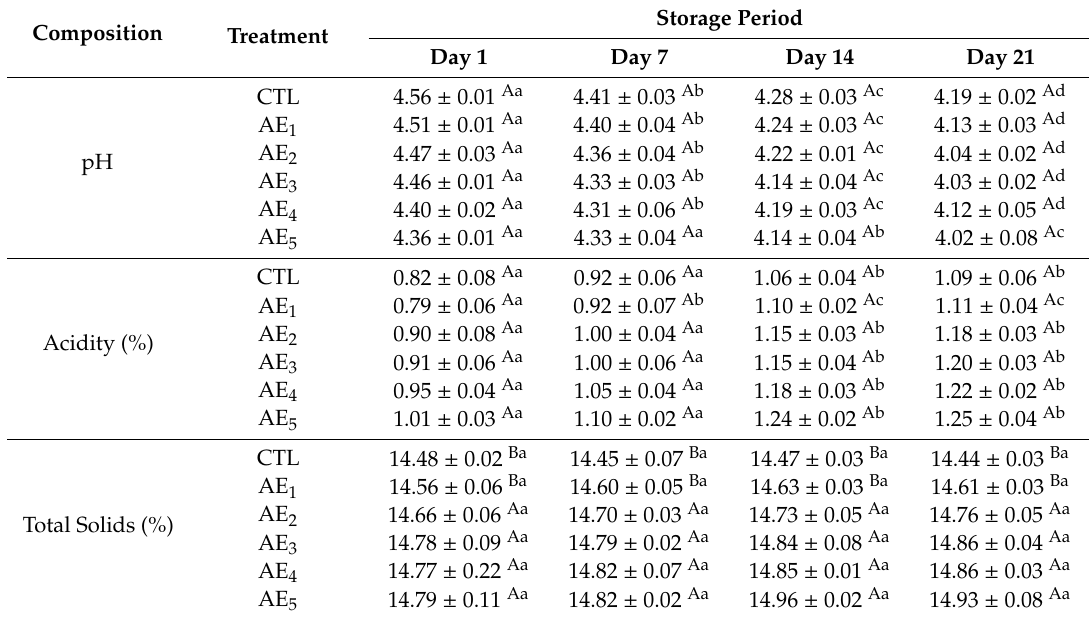
Table 2. Chemical characteristics of probiotic yoghurt with addition of